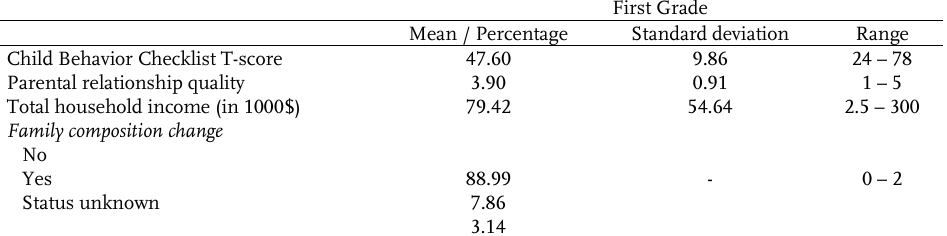
Table 1 : Descriptive statistics